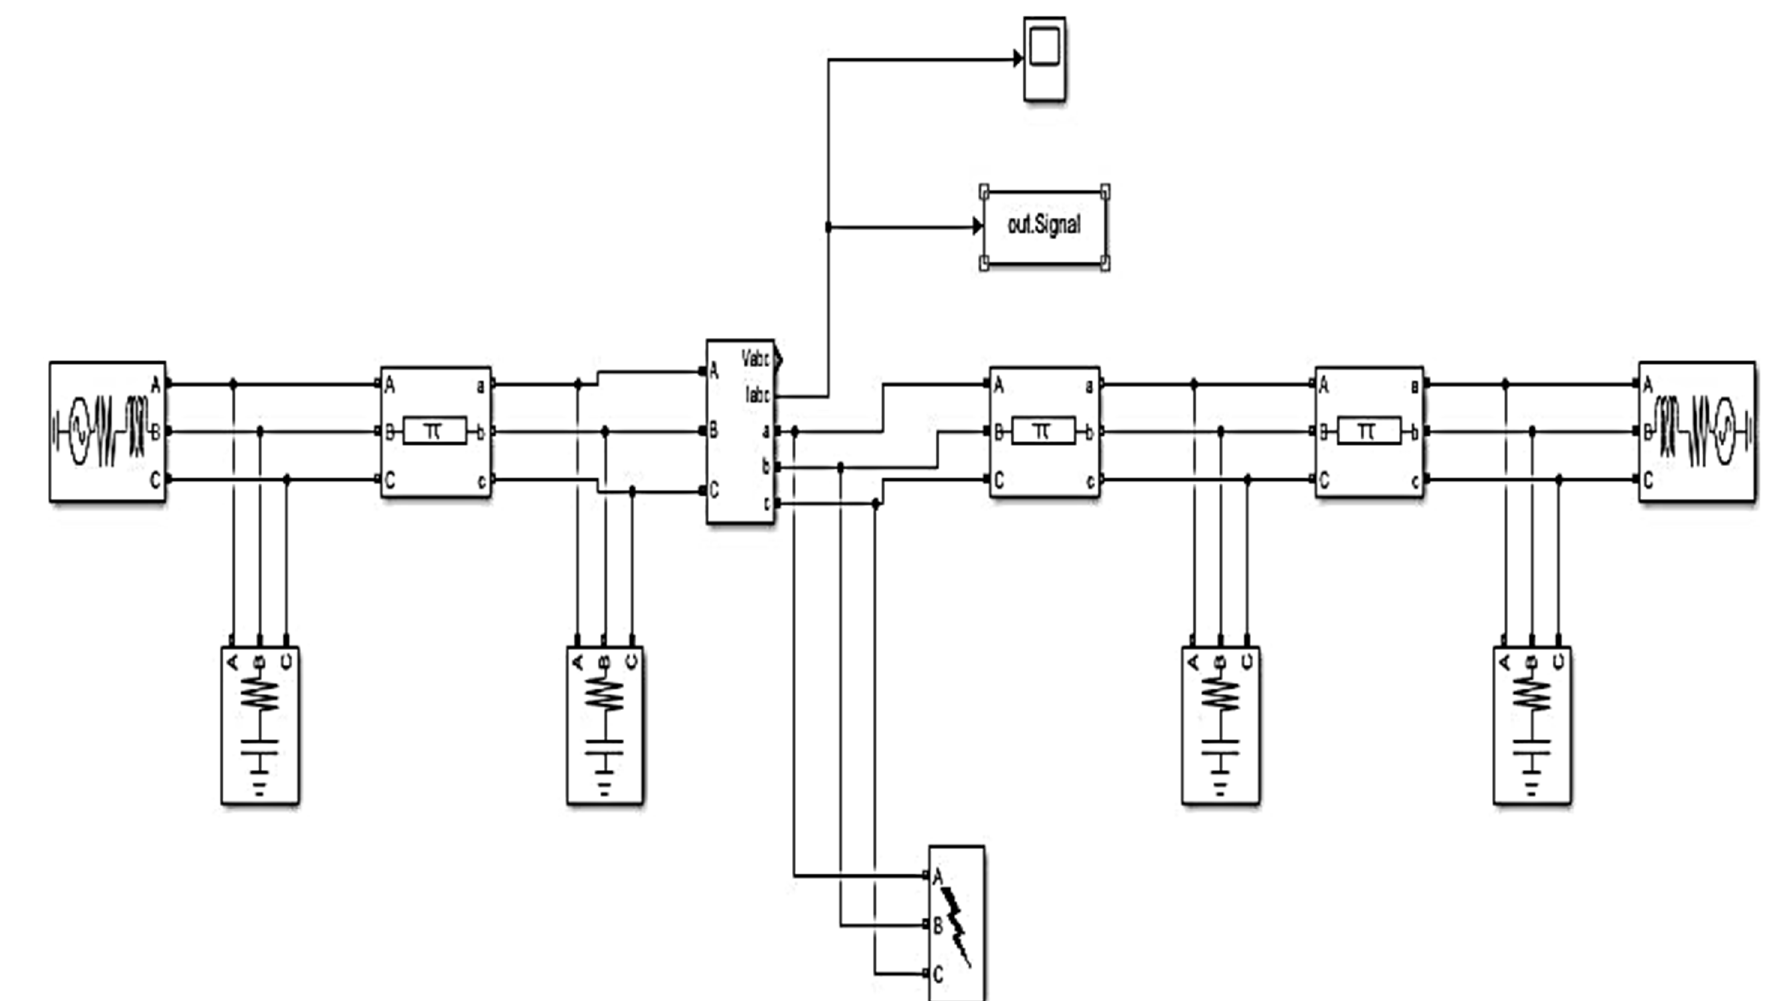
Figure 9. Simulation of the transmission line system .